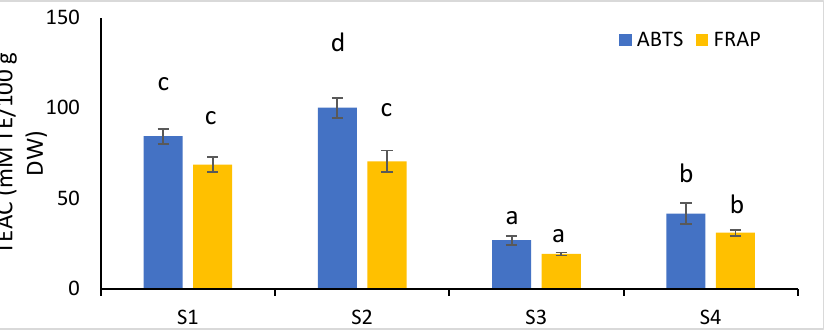
Figure 2. Antioxidant capacity of chokeberry fruit during ripening. S1—unripe green fruits, harvested 20 May; S2—unripe green fruits, harvested 20 June; S3—semi-mature purple fruits, harvested 20 July; S4—ripe black fruits, harvested 20 August; Different letters denote significant differences ( p < 0.05) between dates of fruit harvest, n =